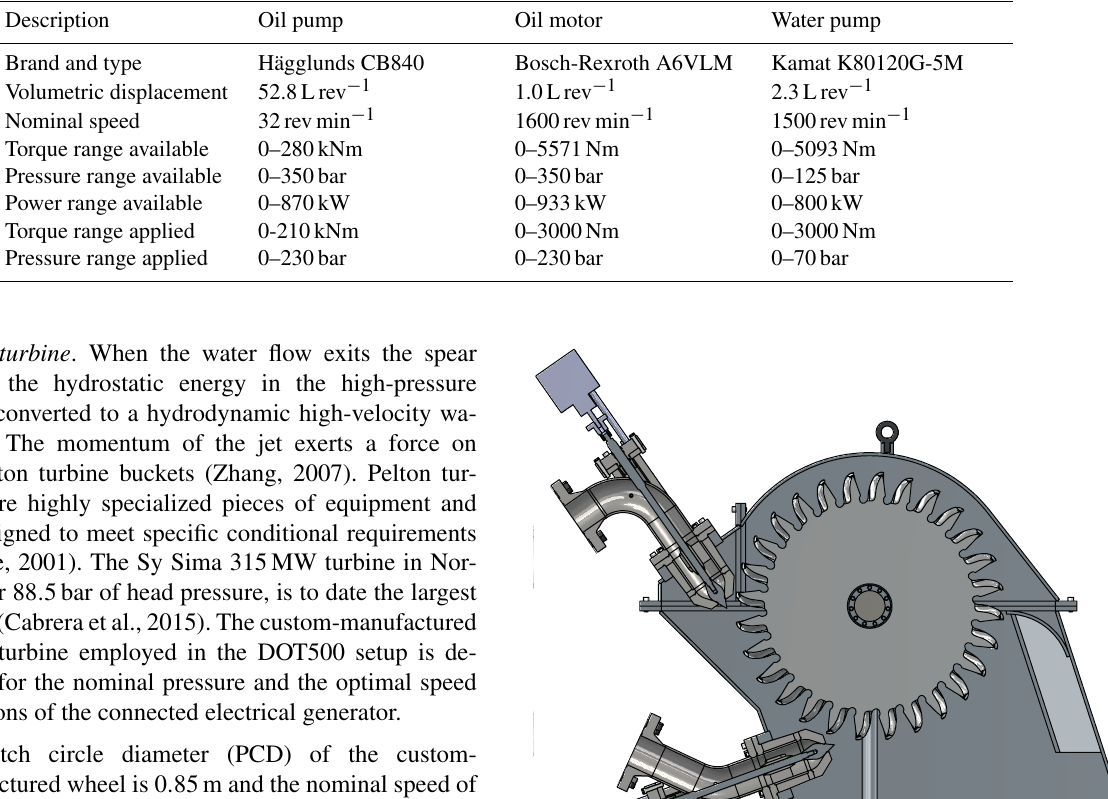
Table 1. Hydraulic oil pump, oil motor, and water pump specifications (Hägglunds, 2015; Bosch-Rexroth, 2012; KAMAT, 2017).